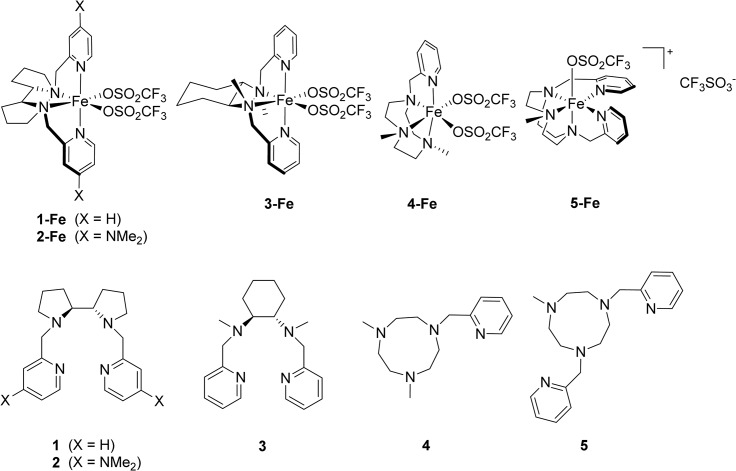
Structures of the iron complexes and the corresponding iron-free organic compounds.